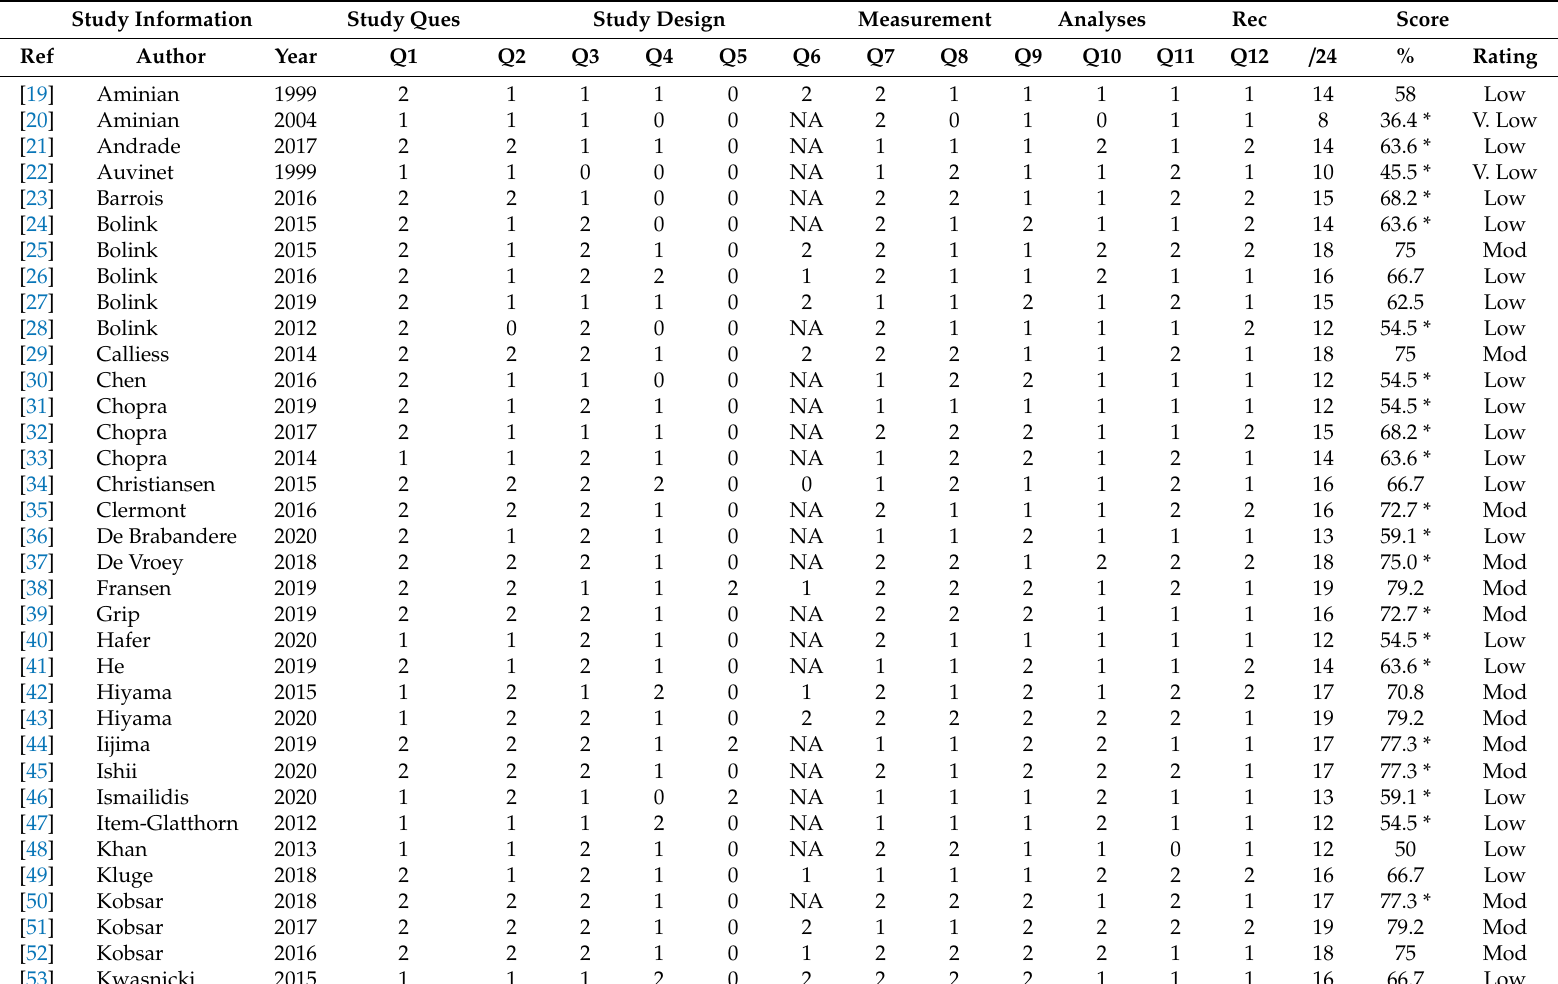
Table 1. Quality assessment scoring of all 72 included